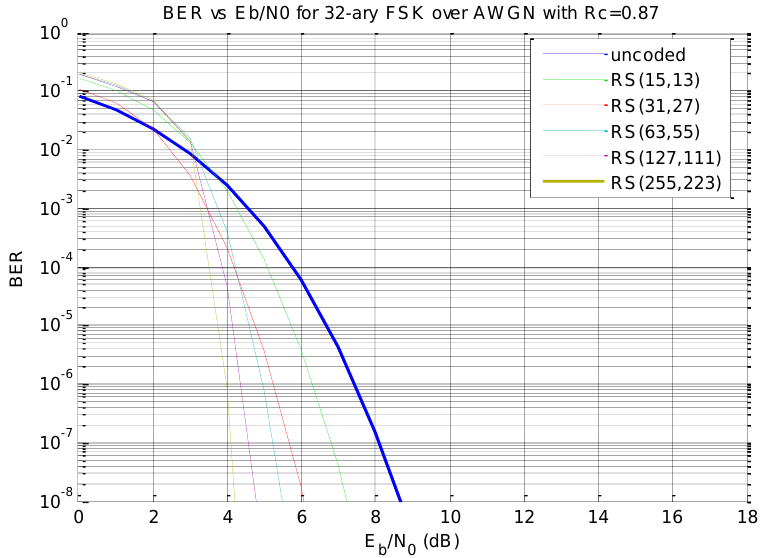
Figure 7. RS error performance for MFSK over AWGN channel with constant R and increasing n